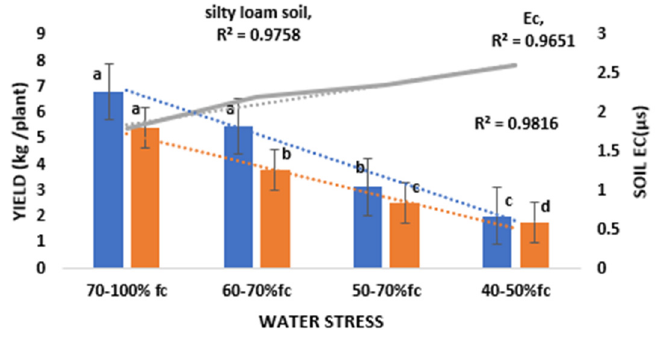
Figure 3. Relationship between sandy loam, silty loam, Ec, and water stress (same alphabet means no significant difference).